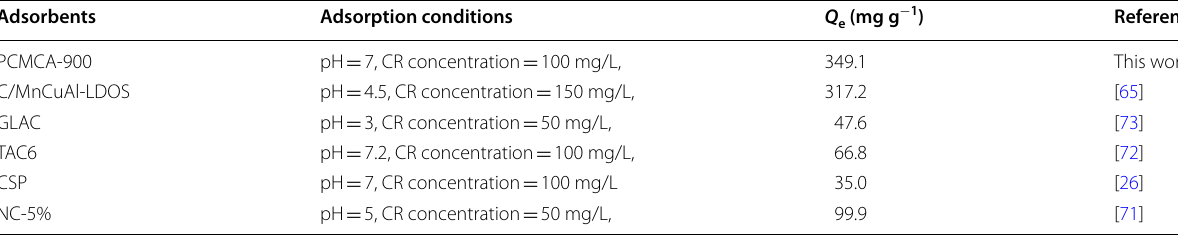
Table 7 Comparison of the CR adsorption capacity of the prepared adsorbent with the reported materials